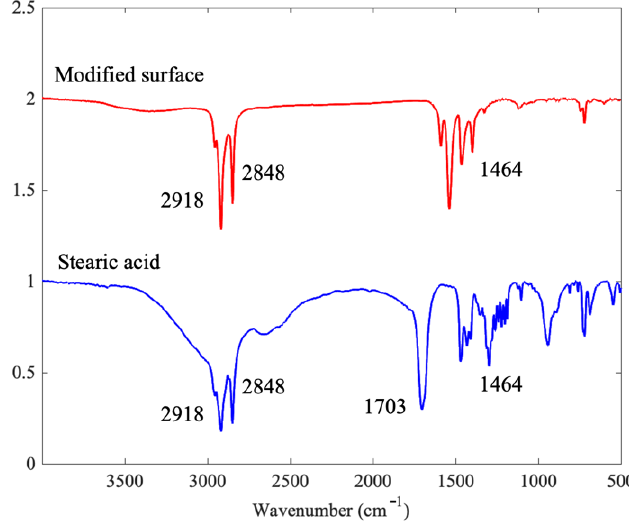
Figure 5. FTIR spectra of stearic acid and stearic copper surface after modification treatment.